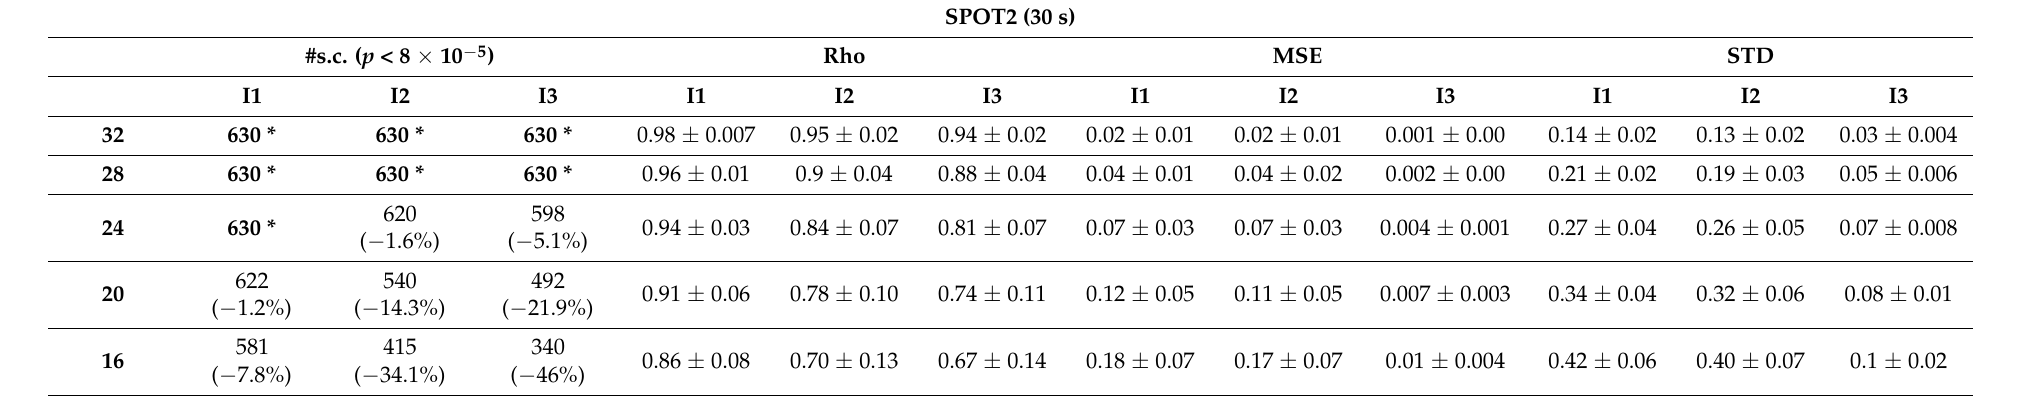
Table 2. Number of significant correlations (#s.c.) and eventual decreasing as percentage of the total number of combinations (630), median ± std of rho, MSE, and STD for the three indices (I1, I2, I3) and the five subgroups of subjects (32, 28, 24, 20, 16) during